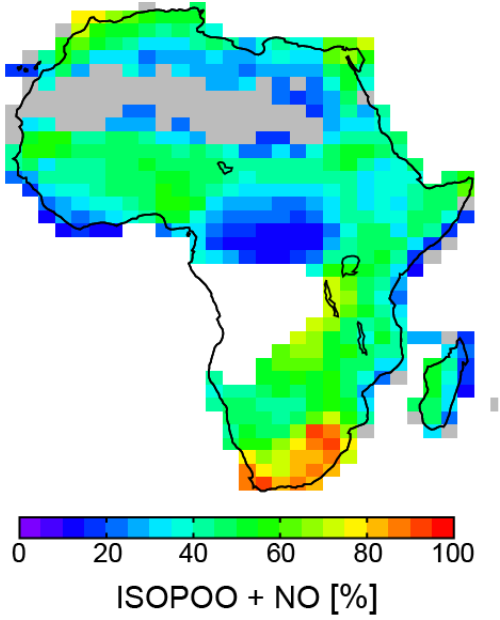
Fig. 6. Percentage of isoprene peroxy radicals (ISOPOO) reacting with NO in the GEOS-Chem simulation for July 2006 using the Paulot scheme for isoprene chemistry. Values are computed from monthly mean reaction rates. Grey gridsquares have zero isoprene emissions in GEOS-Chem and white gridsquares are screened be- cause of biomass burning